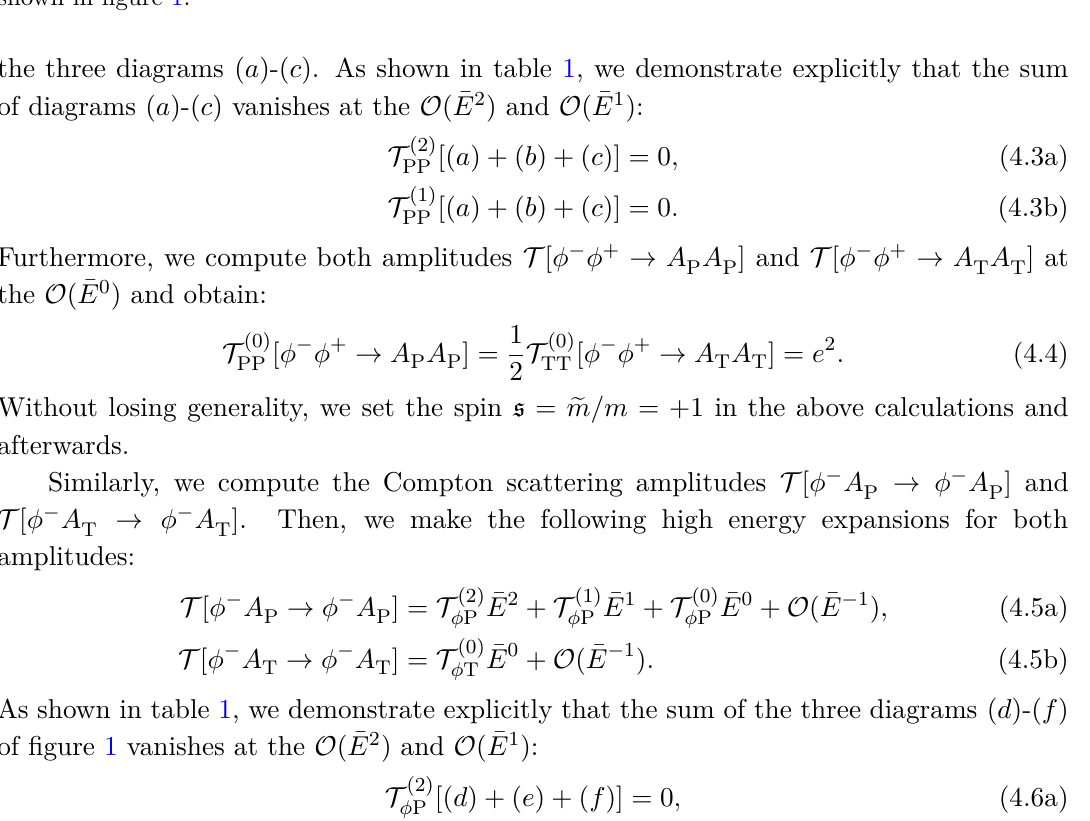
Table 1 . Energy cancellations in the scattering amplitudes of 3d topologically massive scalar QED, T [ φ − φ + → A a A a ] = T [( a )] + T [( b )] + T [( c )] and T [ φ − A a P P PP PP PP T [( f )] , where ¯ E = E/m and ( s , c ) = (sin θ, cos θ ) with θ being the scattering angle. Each full φ P θ θ amplitude equals the sum of individual diagrams ( a ) + ( b ) + ( c ) and ( c ) + ( d ) + ( e ) , respectively,